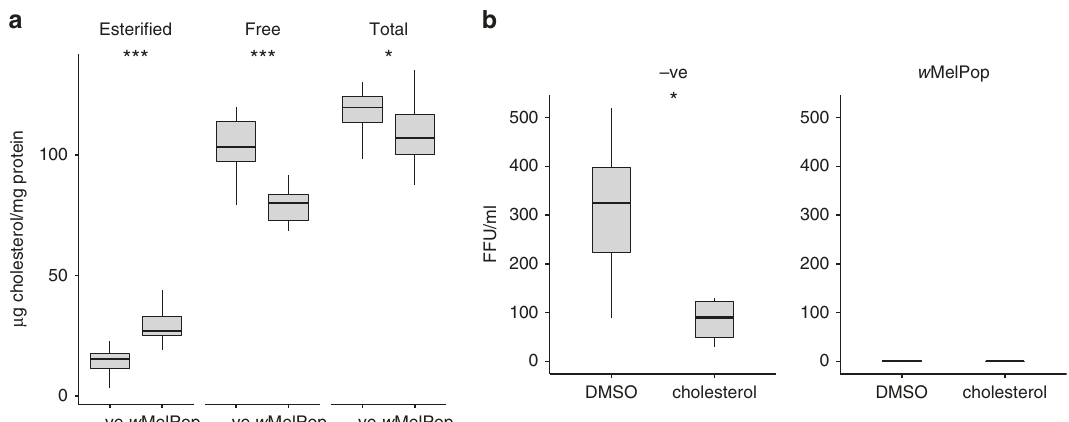
Fig. 1 Infection with Wolbachia is associated with elevated esteri fi ed cholesterol but lower free cholesterol. a Quanti fi cation of esteri fi ed, free and total cholesterol in uninfected ( – ve) and w MelPop-infected Aag2 cells. Quanti fi cation was performed on 12 biological replicates of each cell line. b DENV replication in – ve or w MelPop-infected Aag2 cells. Cells were pretreated with DMSO or 50 µ g/ml cholesterol for 48 h prior to infection with DENV at a multiplicity of infection of 0.1. Cell culture supernatant was harvested 5 days post infection and DENV viral titre ( fl uorescent focus units/ml) measured by fl uorescent focus assay. Statistical signi fi cance was determined with Student ’ s t -test, n =